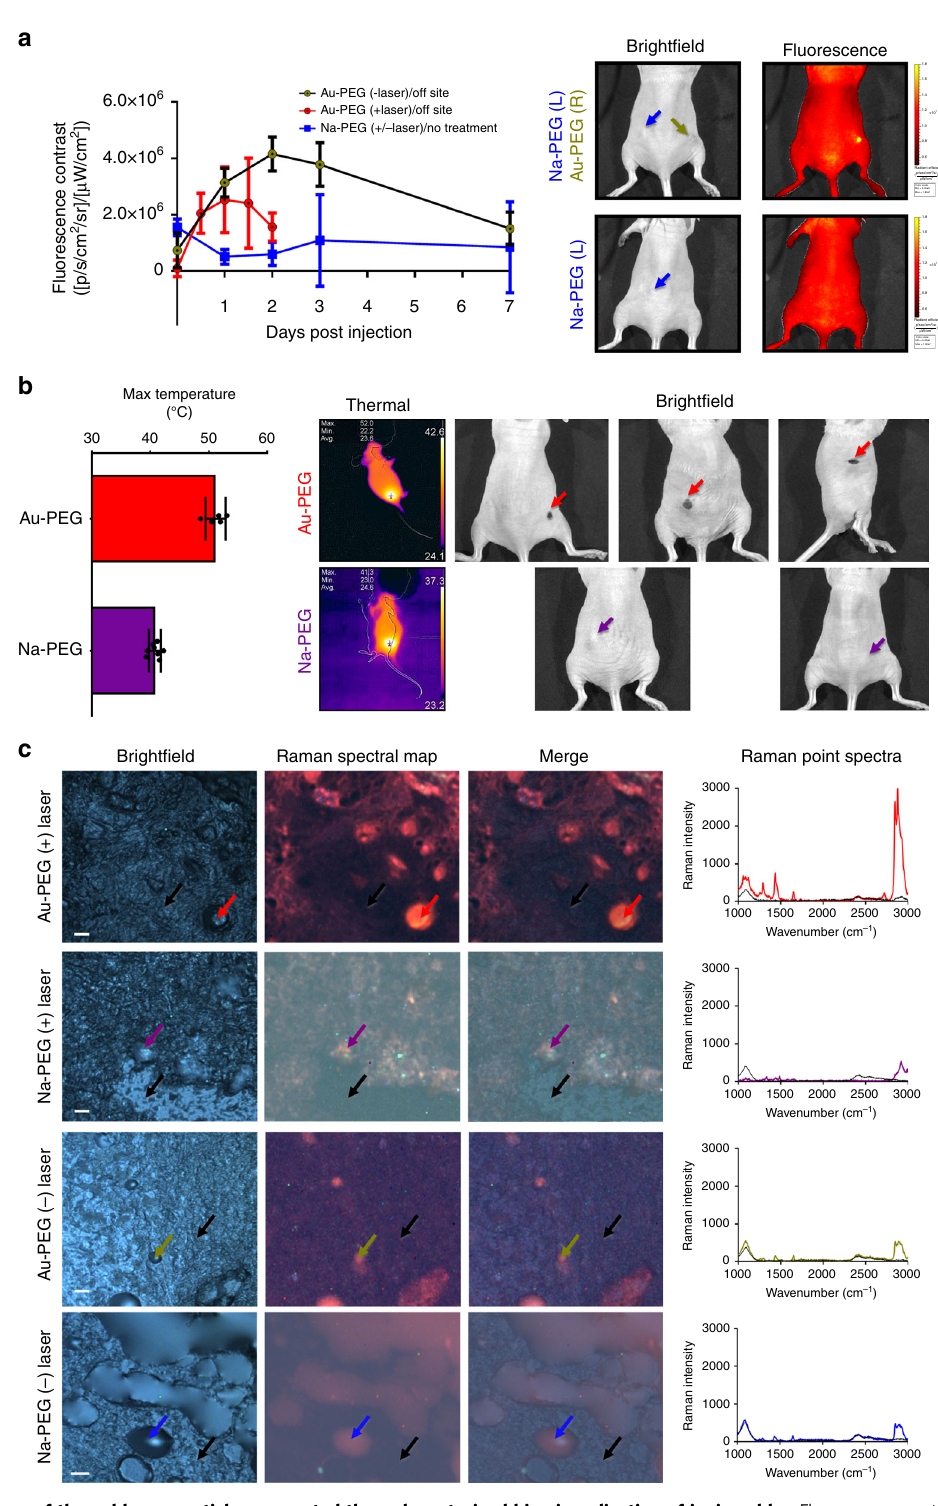
Fig. 7 In vivo ef fi cacy of the gold nanoparticles generated through vectorized biomineralization of ionic gold. a Fluorescence contrast afforded via in vivo imaging system (IVIS)-based imaging (430 Ex 840 Em ) between on-site and off-site across one week period for treatments of Au – PEG with no photothermal treatment (yellow), Au – PEG with photothermal treatment (red), or Na – PEG (blue) with bright fi eld and fl uorescence images representative of Au – PEG or Na – PEG-treated mice (three days post injection) with arrows indicating intratumoral injection sites for Na – PEG (blue) and Au – PEG (yellow). Error bars are standard deviation of the mean ( n ≥ 3 biologically independent animals). b Photothermal effect of intratumorally generated gold nanoparticles via 3 min applications of 500 mW 633 nm laser as represented by maximum surface temperature from the tumors either treated with Na – PEG (purple) or Au – PEG (red) with thermal and bright fi eld images representative of Na – PEG (purple) or Au – PEG (red)-treated mice after two laser applications (thresholding contrast for thermal images are automatically read via the iPad mounted FLIR software). Error bars are standard deviation of the mean ( n ≥ 5 laser treatments). c Bright fi eld, Raman spectral mapped and merged images of excised tumors from mice treated with Au – PEG (± laser ablation) or Na – PEG (± laser ablation) with corresponding Raman point spectra for positions designated with arrows. Scale bars are 20 µ